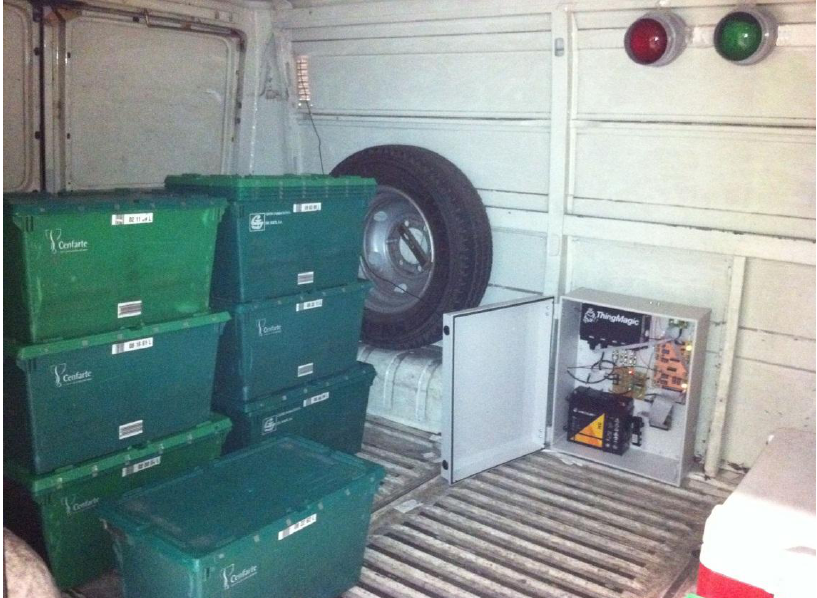
Figure 13. Onboard system deployed on a vehicle. The transport bins of green color with the corresponding RFID tags can be seen on the left hand side of the